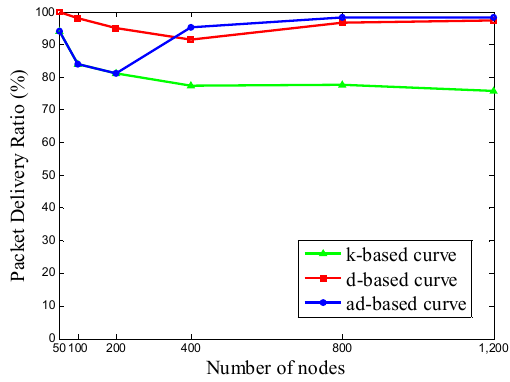
Figure 8. The PDR of the k-based, d-based and adjustable d-based trajectories.